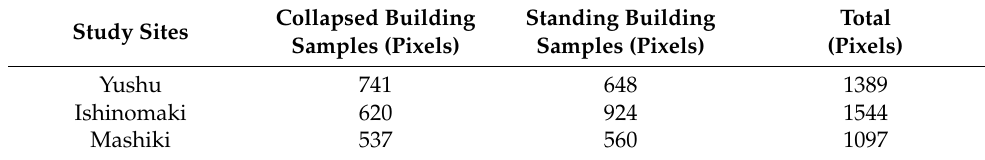
Table 6. The number of samples for multi-feature-based collapsed and standing buildings classifica- tion in three study